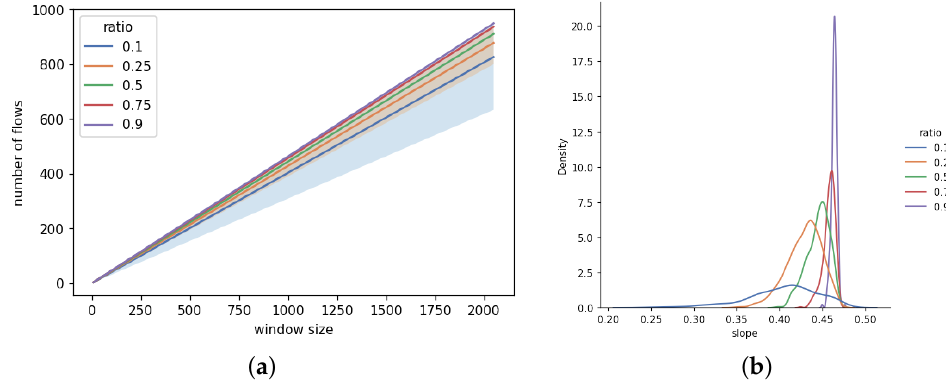
Figure 9. ( a ) Linear fit f ( n ) = an of (cid:98) W ( n ) —a number of fragment flows as a function of packet window size. Shaded areas represent the two widest confidence regions of the slope. ( b ) The Gaussian kernel density estimation of the distribution of the slope a for each